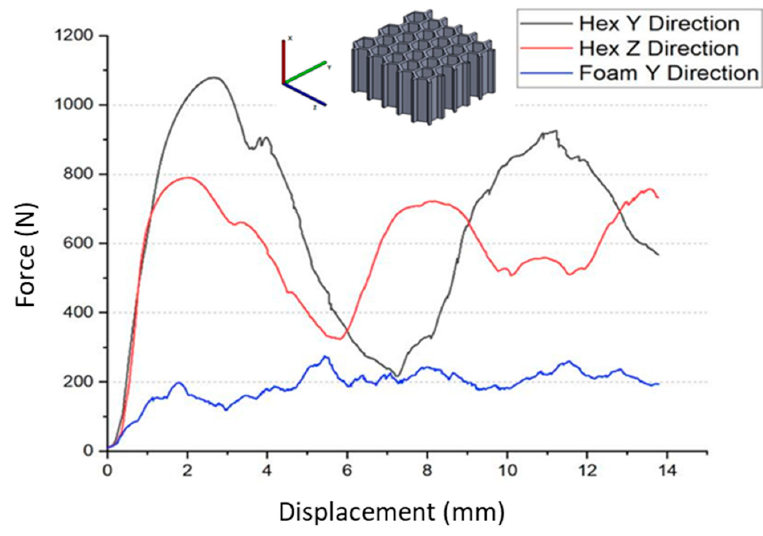
Figure 5. Force–displacement curves of the cast honeycomb and foam specimens.